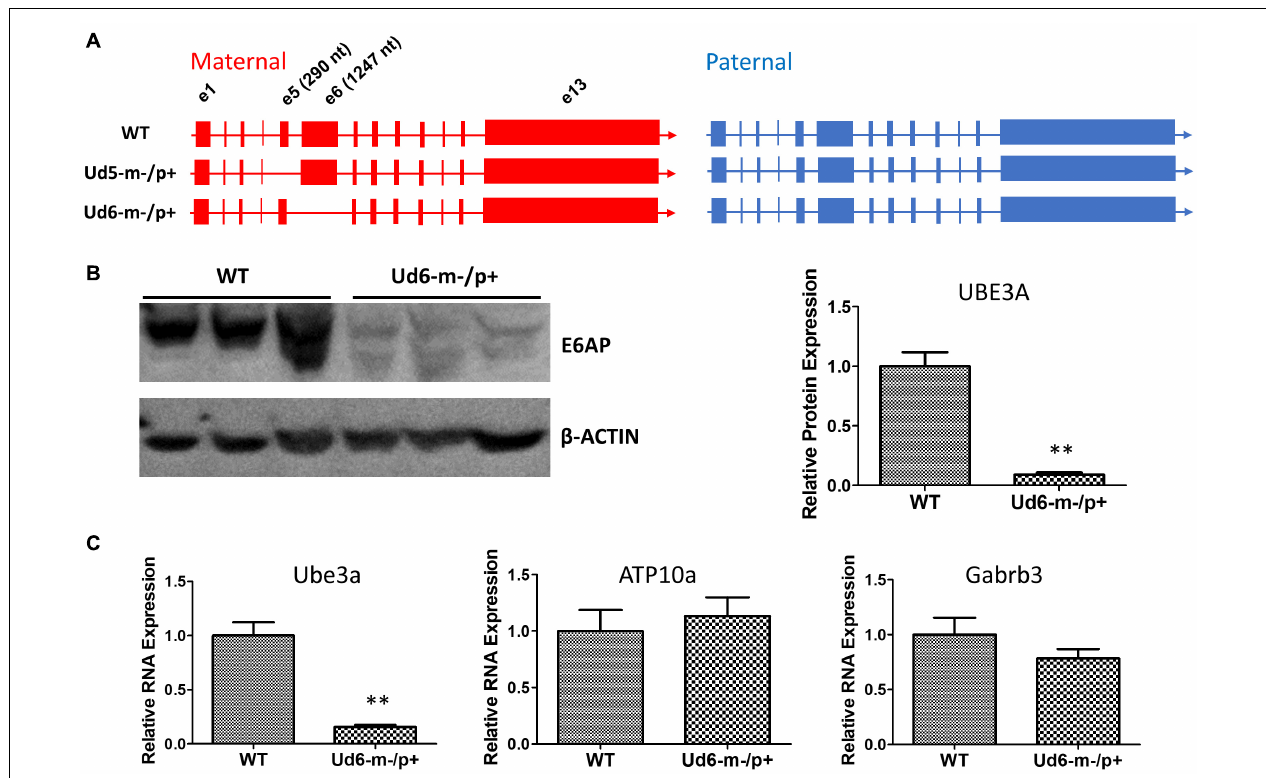
FIGURE 1 | Ube3a is imprinted in the brain of the Ud6-m-/p+ mouse. (A) Female mice harboring one Ube3a knockout allele (left panel) were crossed with wild-type background (WT C57BL/6J) male mice (right panel) to obtain the maternal deletion Angelman model mice. The maternal and paternal Ube3a allele arrangements are WT (upper), the original Angelman model mouse strain harboring an exon 5 deletion in Ube3a gene, Ud5-m-/p+ (middle), and the new strain knockout of exon 6 in the Ube3a gene, Ud6-m-/p+ (lower). (B) Left panel, immunoblots for UBE3A protein in the cerebellum of Ud6-m-/p+ and WT mice. β -Actin serves as the loading control (each lane comes from a separate mouse; one representative immunoblot is shown). Right panel, densitometric analyses of the immunoblot (the expression of WT is normalized to 1.0, n = 3 for both WT and Ud6-m-/p+). ∗∗ p < 0.01 by two-tail unpaired T test, error bars are SEM. (C) Ube3a , ATP10a , and Gabrb3 mRNA transcript abundances in cerebellum of Ud6-m-/p+ and WT mice were quantified by real-time PCR ( n = 3 for both WT and Ud6-m-/p+). ∗∗ p < 0.01 by two-tail unpaired T test, error bars are